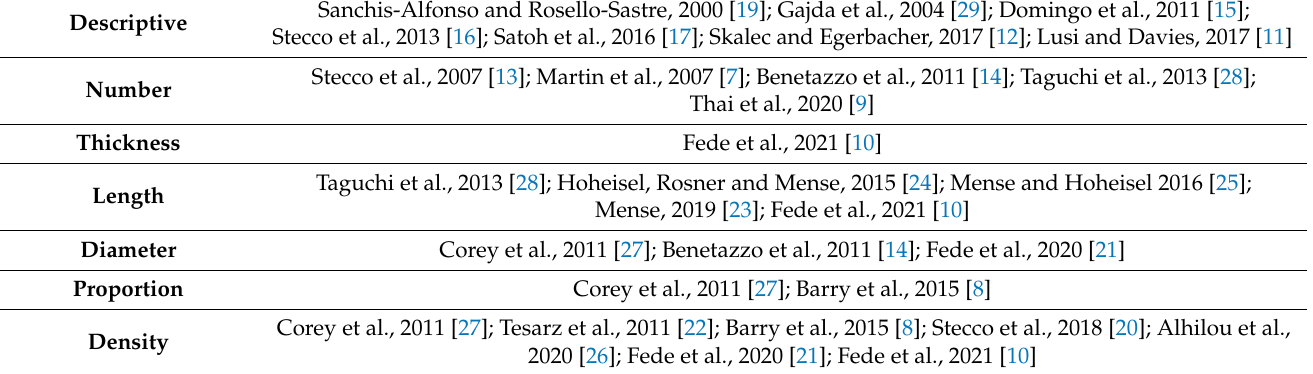
Table 4. Nerve fibers